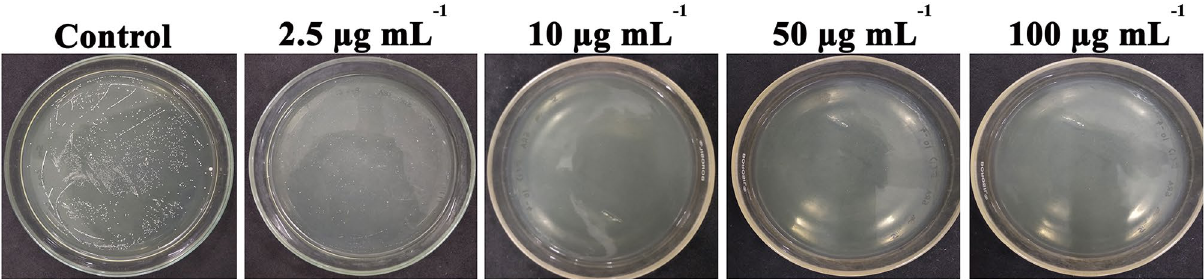
Figure 6. Spontaneous resistance frequency of S. mutans to UA. No resistant colonies were zxobserved in the MIC or higher concentration of UA which indicates that UA is a promising agent to treat cariogenic pathogen S. mutans .